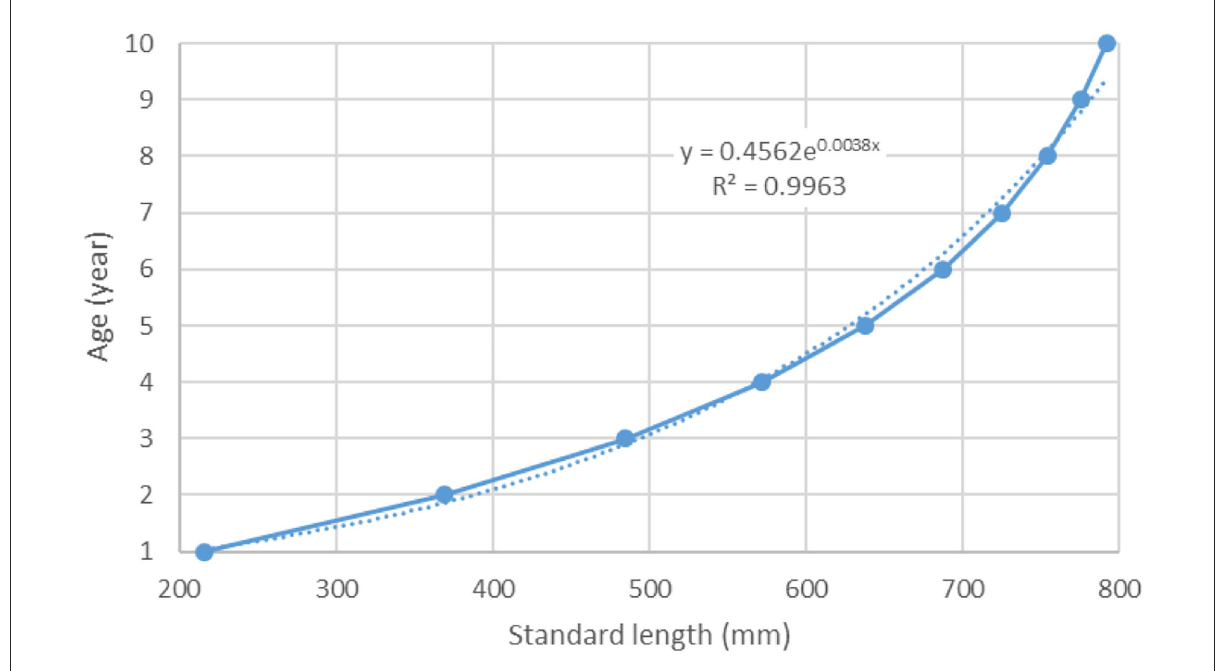
FIGURE7 Age-length relationship of Chinese sea bass.